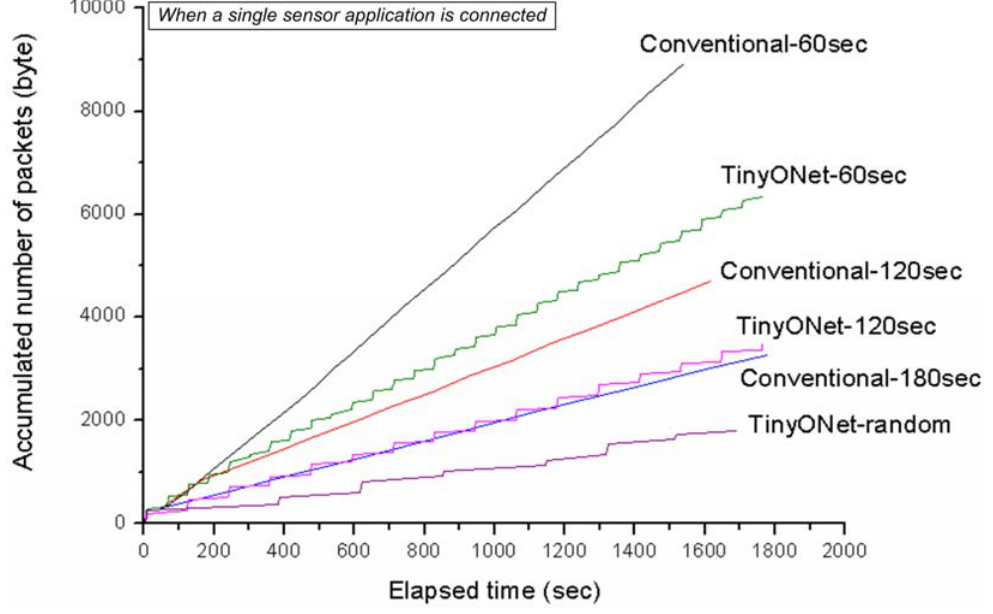
Figure 12. Accumulated number of packets on the TxRx